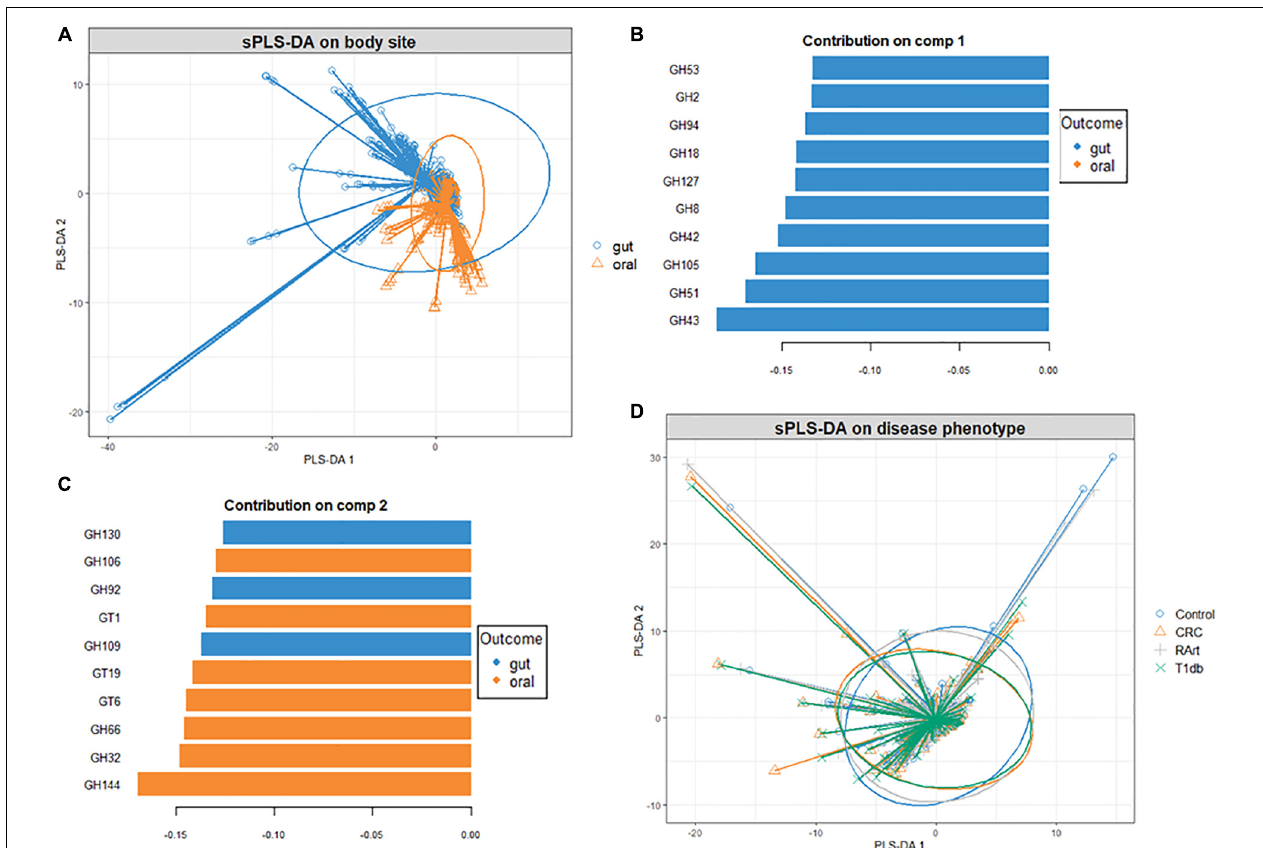
FIGURE 6 | Supervised analysis and feature selection with sparse PLS-DA. Sample plots with 95% confidence ellipses showing clustering of the CAZyme abundance according to body site (A) . Loading weights of the most important CAZyme families selected on components 1 (B) and 2 (C) of the sPLS-DA model with body site as a categorical variable. Fill colors indicate the body site in which the CAZyme is most abundant. Only the top ten CAZymes are displayed. Sample plots with 95% confidence ellipses showing clustering of the CAZyme abundance according to disease condition (D)